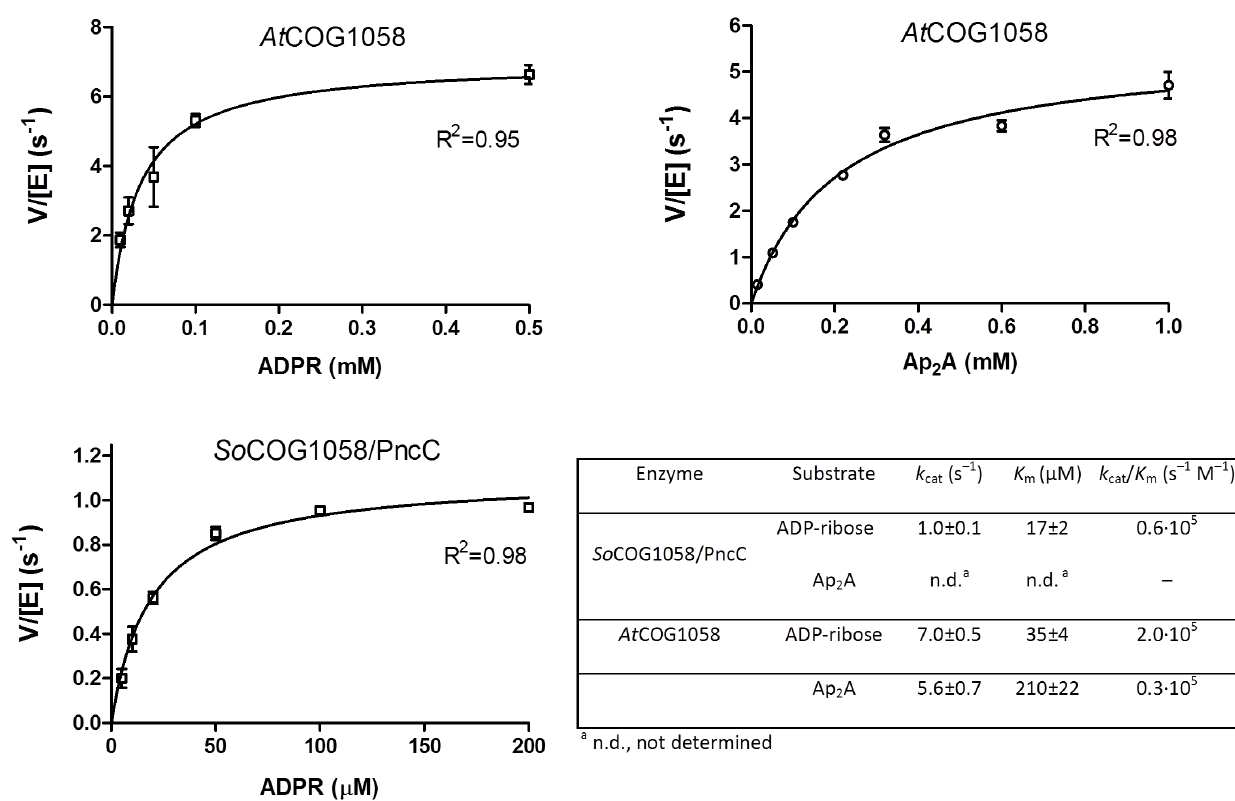
Figure 5. Kinetic characterization of So COG1058/PncC and At COG1058 enzymes. Plots of the initial velocities of the catalyzed reactions versus substrate concentrations. Kinetic parameters, calculated as described in Materials and Methods, are reported in the